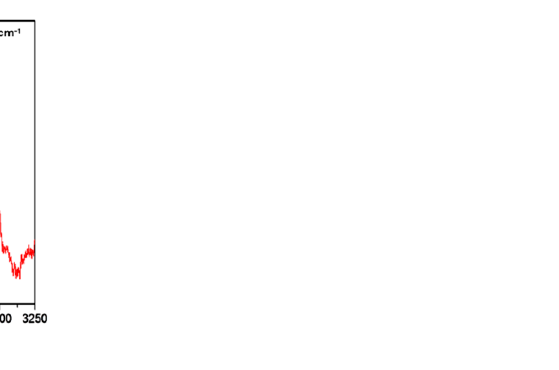
Figure 1. Raman spectra of a single cell of E. coli spotted on a golden substrate with respective band assignment. Table 1. Raman bands assignments to functional groups and corresponding biomolecules. Raman Shift (cm − 1 )